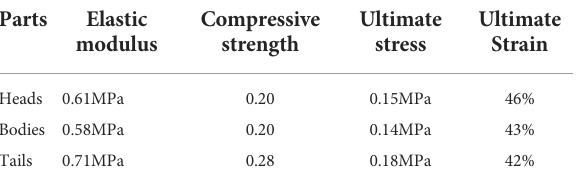
TABLE 1 Materialparametersofdifferentpartsofthe Harpadonnehereus